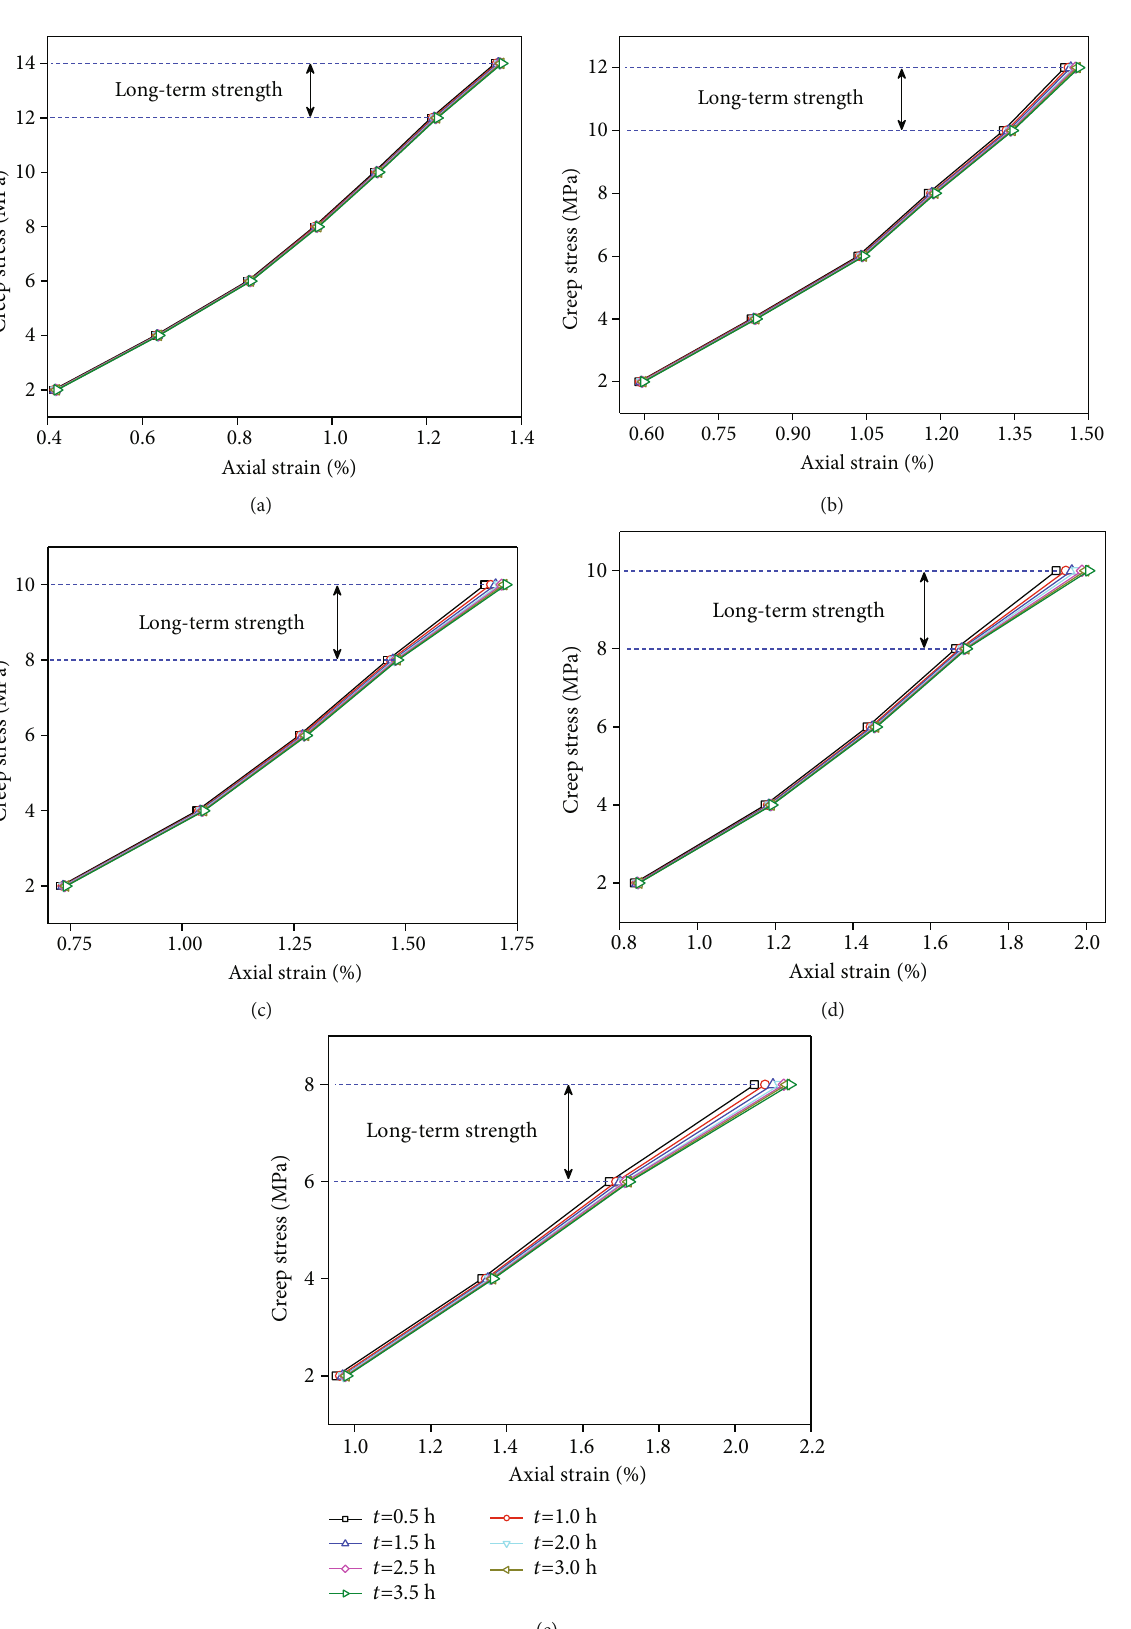
Figure 10: Isochronous stress-strain curves of coal specimens under di ff erent water contents: (a) ω = 0 % , (b) ω = 2 : 42 % , (c) ω = 5 : 53 % , (d) ω = 7 : 55 % , and (e) ω = 10 : 08 %